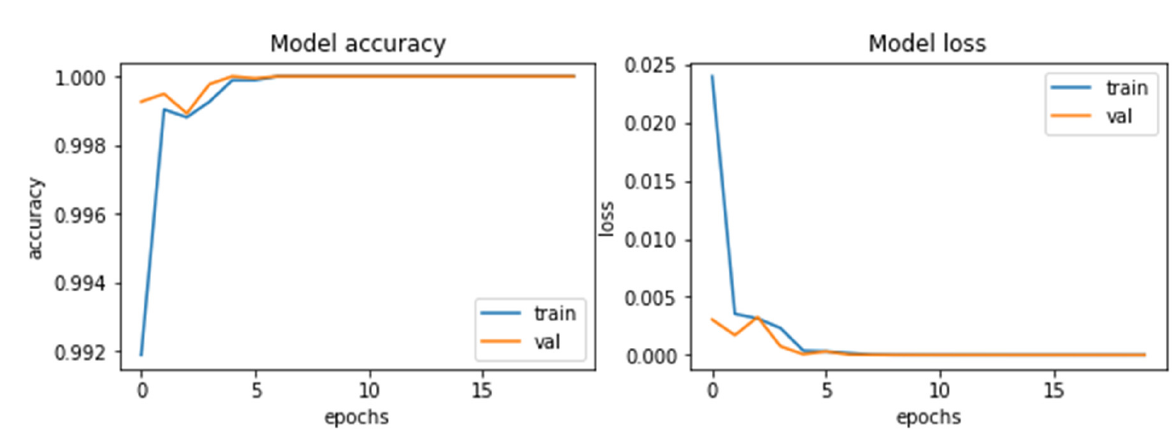
Figure 16. Accuracy and loss curves of ResNet50 architecture.